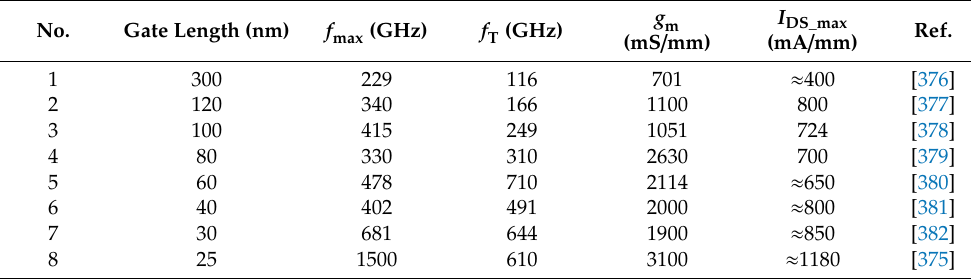
Table 3. Direct Current (DC) and Radio Frequency (RF) performances of some classical InP HEMTs [350]. No. Gate Length (nm) f max (GHz)